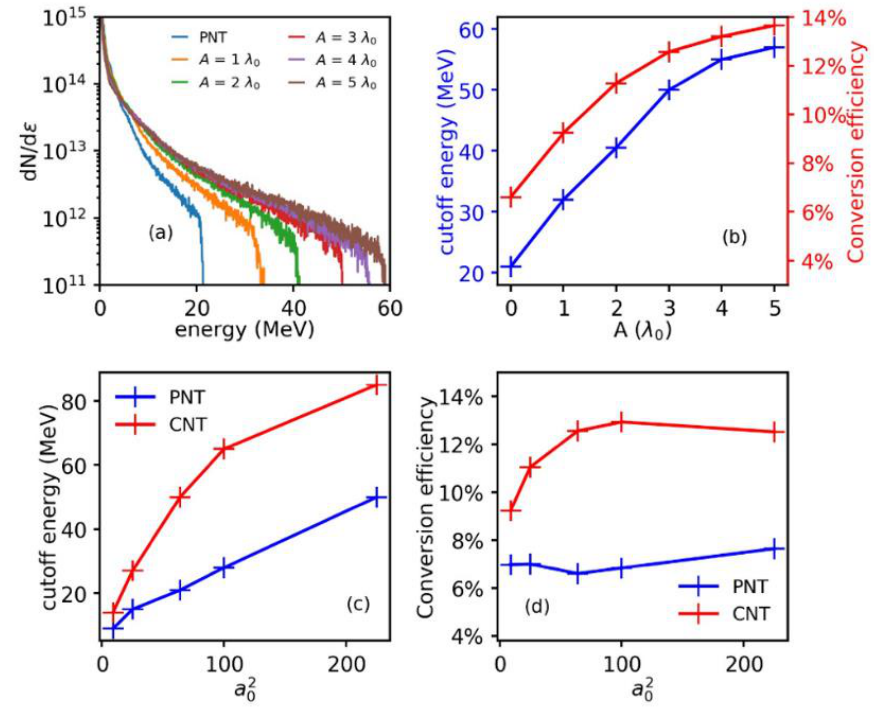
Figure 5. ( a ) Energy spectra of protons with different A . ( b ) Cut-off energies of protons and conversion efficiency versus A . ( c , d ) Cut-off energies and conversion efficiency versus laser intensity ( a 02 ) for the PNT and the CNT, respectively.